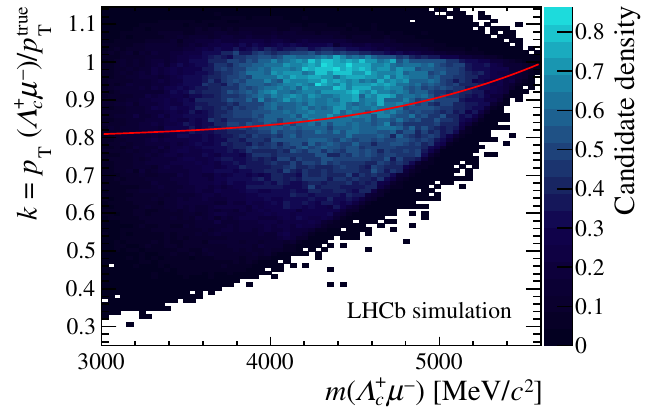
Figure 2 . Distributions of the k -factors in simulated data as a function of the (cid:3) + The average correction k ( m ( (cid:3) + (cid:22) (cid:0) )) is overlaid in red. The colour code describes the normalised c density of the